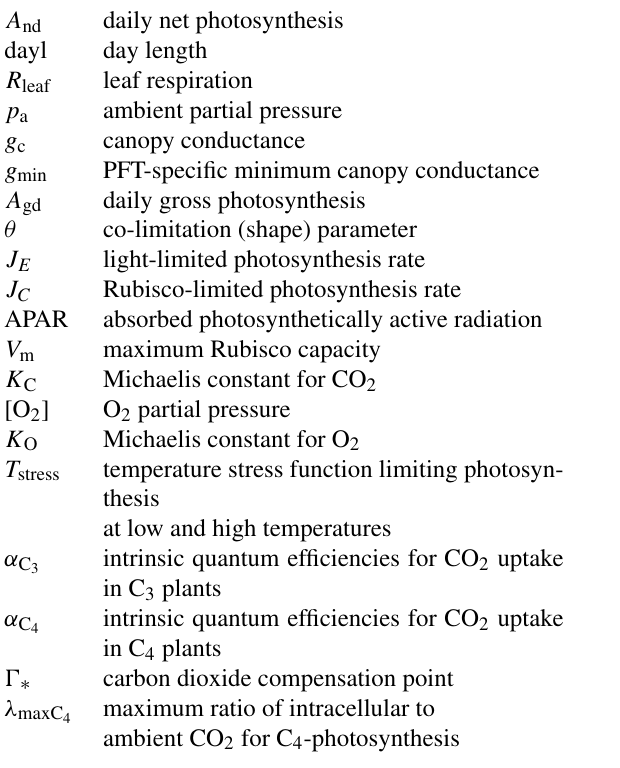
Table A1. PFT-specific parameter for temperature stress function (Eq. 12) in ◦ C. PFT types as in Schaphoff et al. (2018a). Plant functional type